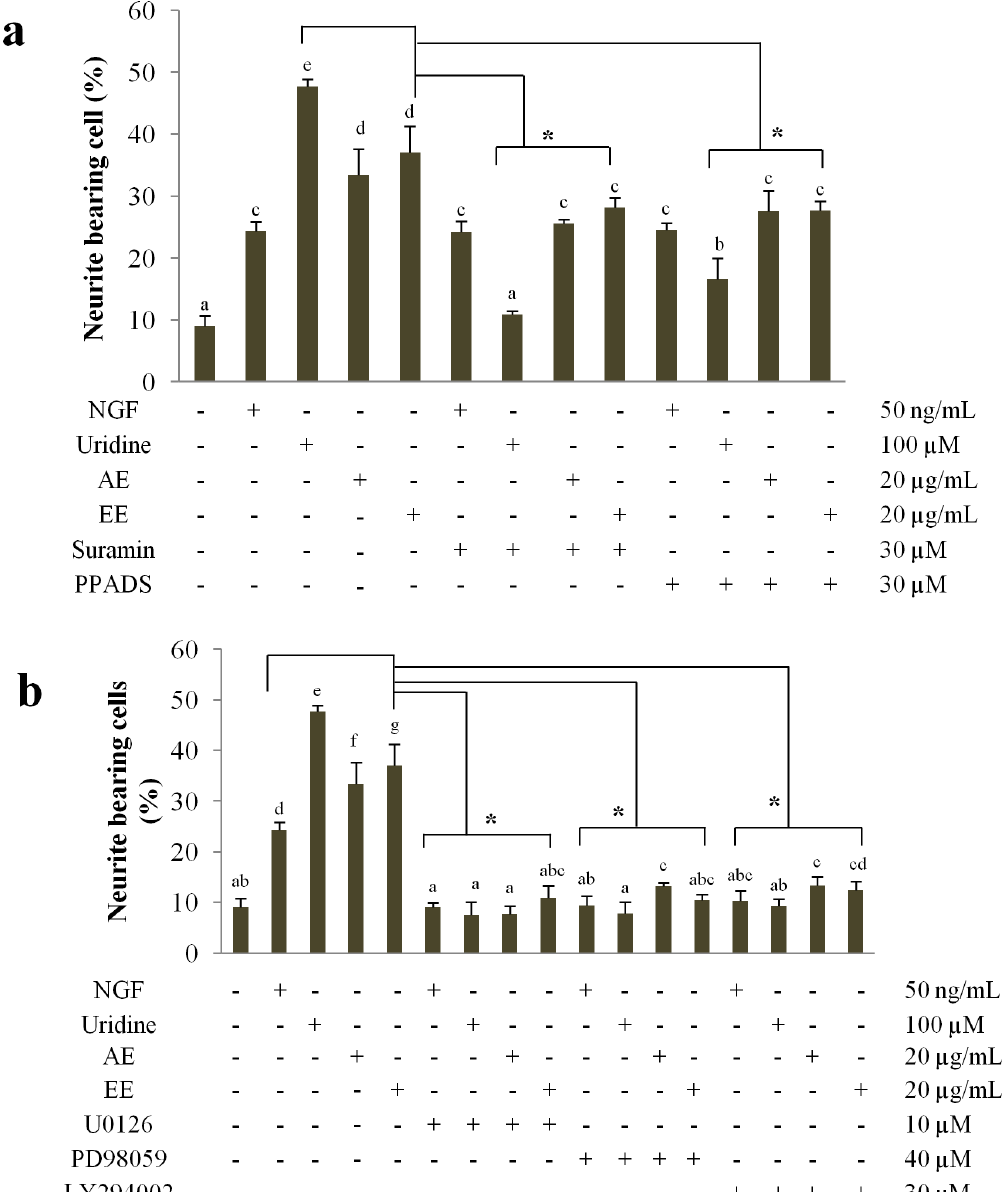
Fig 5. (a) The effects of two specific inhibitors of P2Y receptors (suramin and PPADS) on neurite outgrowth of differentiating N2a cells. (b) The effects of specific inhibitors of MEK/ERK and PI3K/Akt pathways (U0126 & PD98059; and LY294002, respectively) on neurite outgrowth of differentiating N2a cells. NGF (50 ng/mL) was used as positive control and medium only with no treatment was used as control. Aqueous (AE) and ethanol extracts (AE; 20 μ g/mL) were tested to compare with uridine. Values are mean ± SD from three independent experiments. Different alphabets represent significant differences between samples. * p < 0.05 significantly lower relative to group without inhibitor